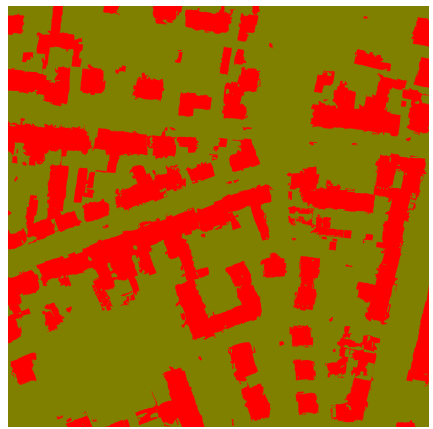
Figure 3. Extracted building from rule-based